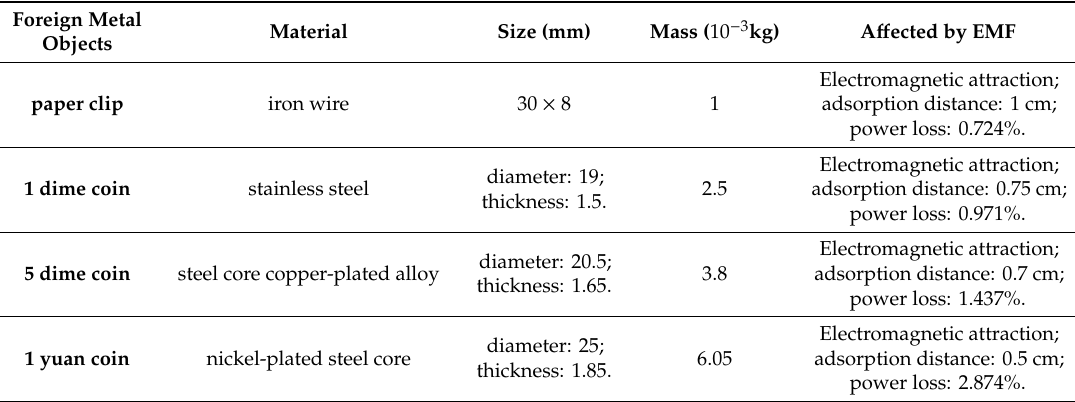
Table 2. Basic parameters and force of common foreign metal objects.